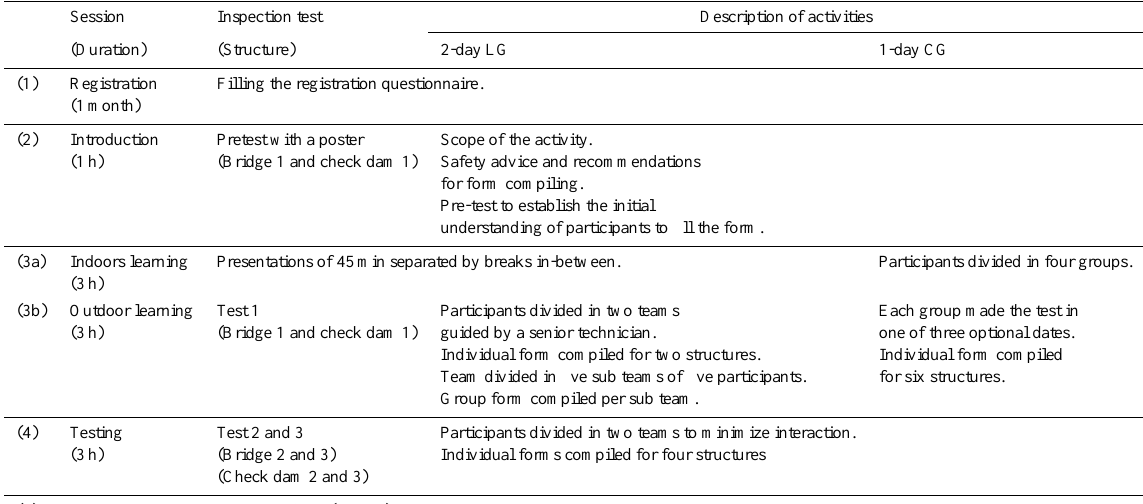
Figure 1. Study area: (a) overview of the study area and Fella Basin. (b) Map indicating the location of the structures for the inspection tests. Table 4. Description of the data-collection